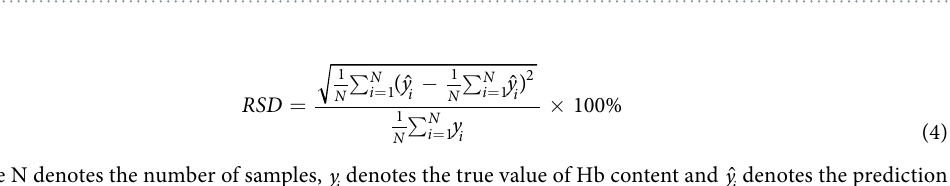
Figure 11. Dynamic spectra from randomly selected samples with different Hb contents. ( a ) Normal Hb contents. ( b ) High Hb